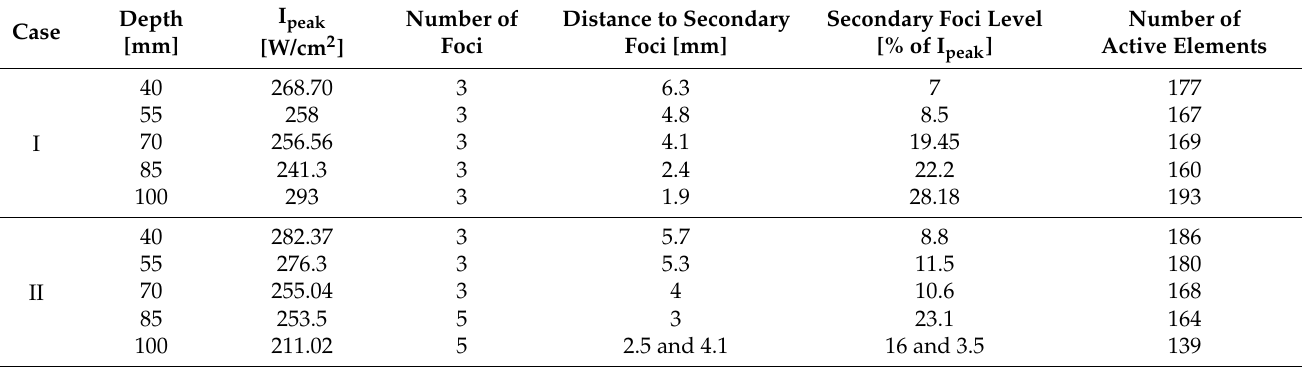
Table 2. Intensity distribution and focal quality for anatomical ribs, when the array axis passes through the ribs (case I) and the intercostal space (case II). The results shown are for a single focus targeted at the geometric focus of the array.